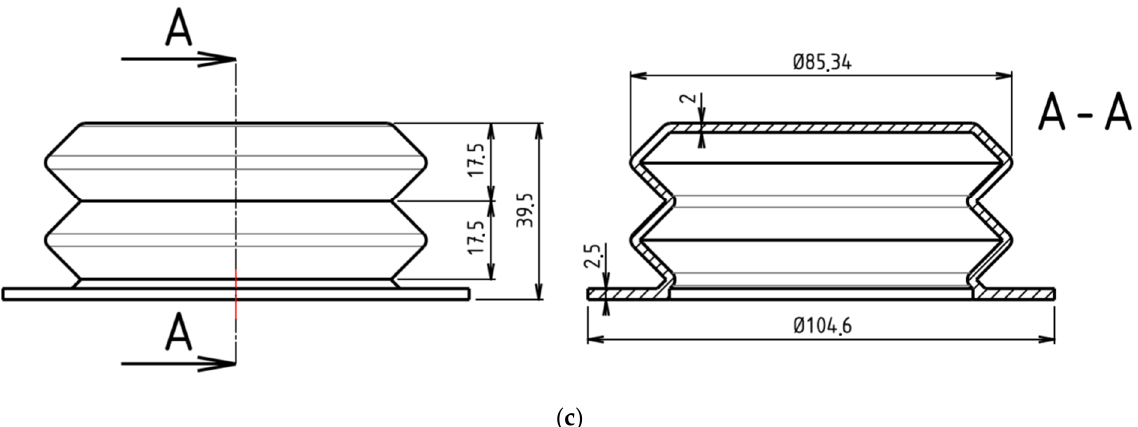
Figure 2. Manufacturing process of the module (left: casting, right: part of the inside surface). (a) Mold, (b) white inside, and (c) dimensions of the bellow (in mm).